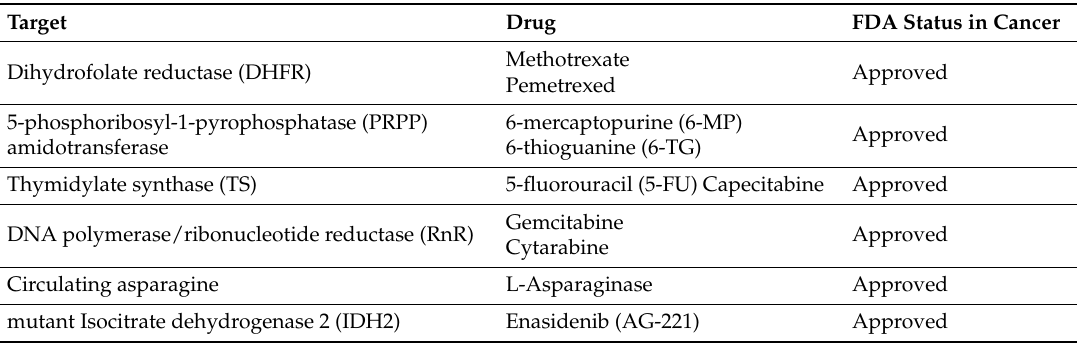
Table 1. Approved drugs targeting specific metabolic aspects of the cancer metabolism.